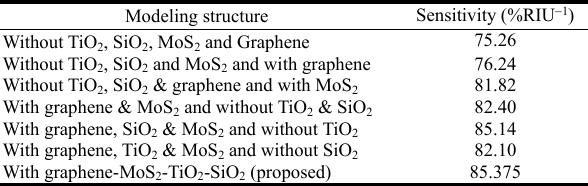
Table 5 Analysis of sensitivity corresponding to sensing layer refractive index at 1.41 RIU for seven different structures at the optimum thickness of TiO 2 -SiO 2 and monolayer of MoS 2 and